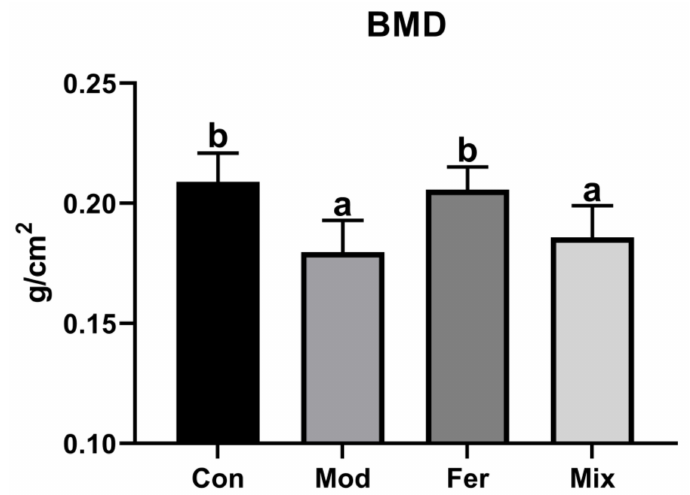
Figure 2. FS more significantly restored BMD in osteoporotic rats. Three groups of female rats were injected intramuscularly with dexamethasone to induce osteoporosis, and the rats in the Con group were injected with an equal volume of saline. Meanwhile, the Fer group was intragastrically administered 1 mL/100 g of FS, the Mix group was intragastrically administered 1 mL/100 g of MS, and the Con and Mod groups were intragastrically administered an equal volume of sterile water. After execution, double-energy X-ray absorptiometry (Lunar iDXA, GE) was used to analyze the BMD of the left femur. The values are given as mean ± SD (n = 6). With p < 0.05, values with various superscript letters differ significantly.